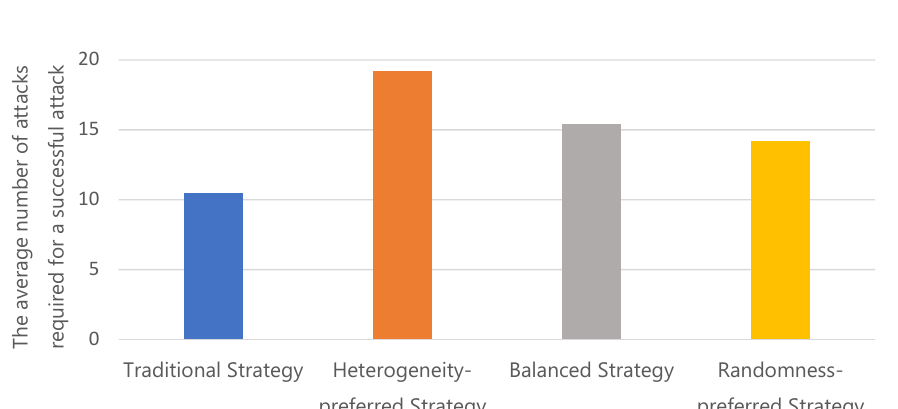
Figure 7. The average number of attacks required under the random attack